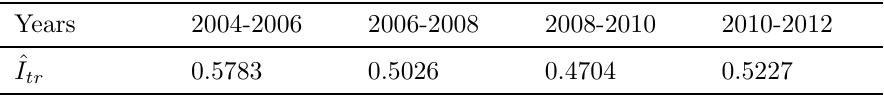
Sampling trace indices.